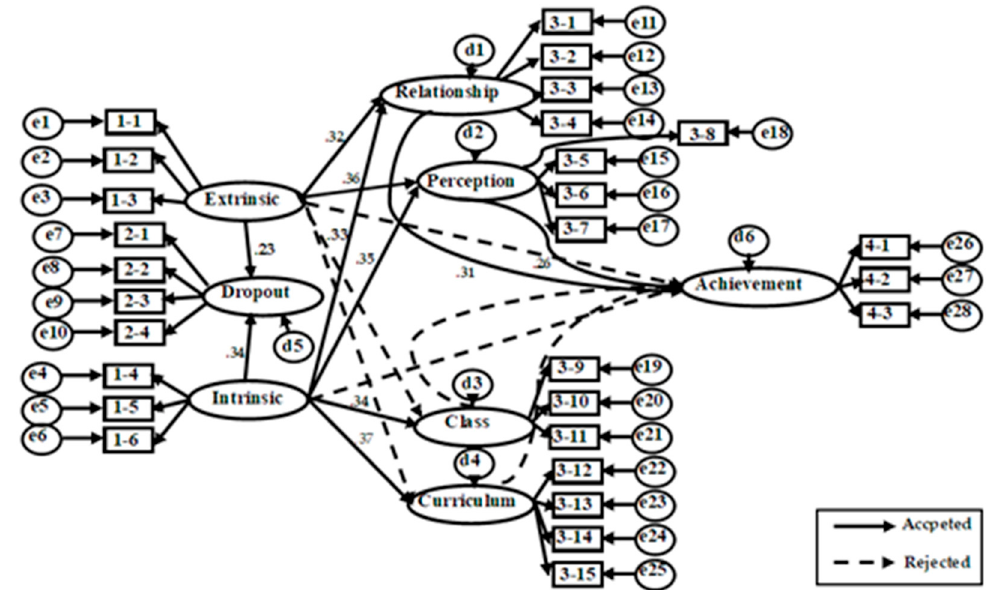
Figure 2. Final Path Analysis